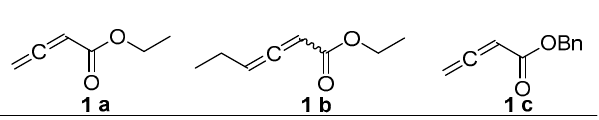
Figure 1. Types of Figure 1. Types of allenes.